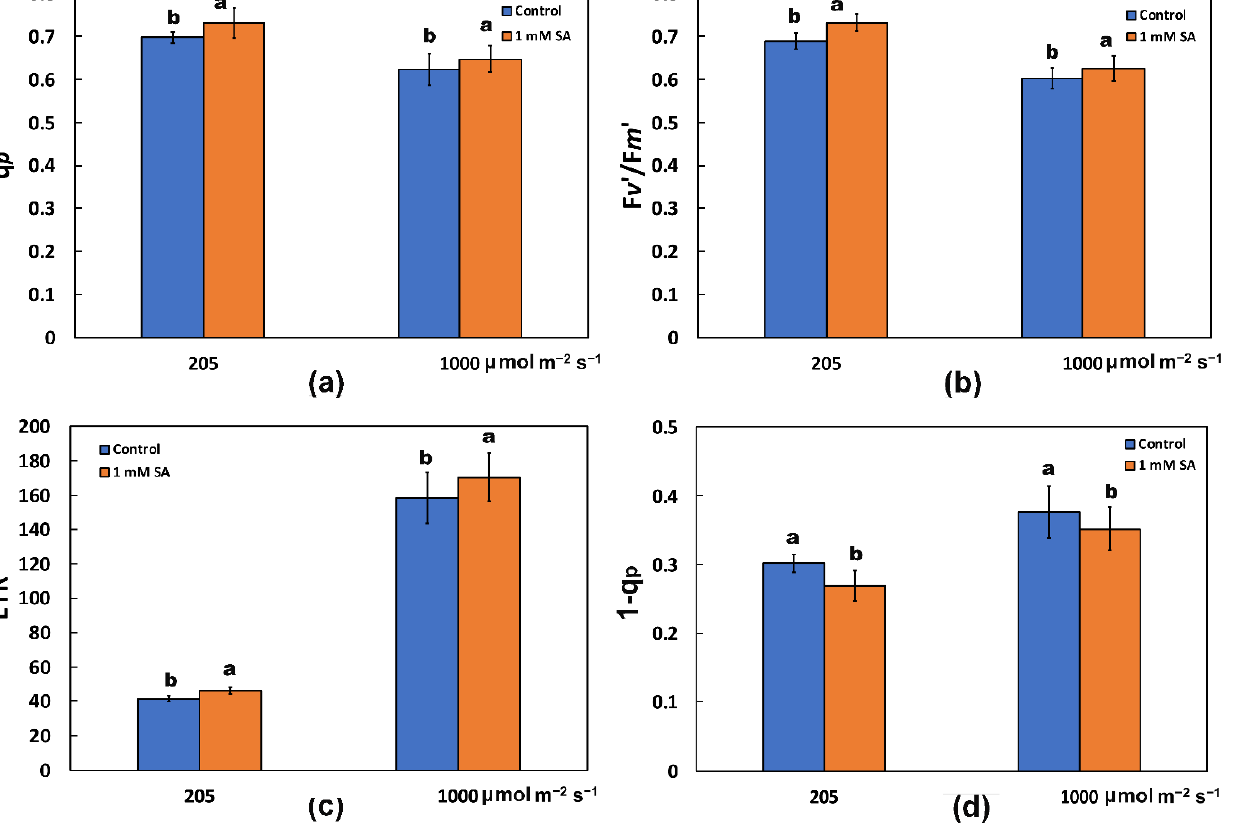
Figure 2. The fraction of open PSII reaction centers (q p ), a measure of the redox state of quinone A (Q A ) ( a ); the efficiency of excitation energy capture by open photosystem II reaction centers (F v ’/F m ’) ( b ); the electron transport rate (ETR) ( c ); and the excitation pressure (1 − q p ) (data from a) ( d ); estimated at 205 and 1000 µ mol photons m − 2 s − 1 actinic light (AL) intensity in tomato leaves, after 72 h of foliar spray by either distilled water (control) or 1 mM salicylic acid (SA). Error bars are standard deviations ( n = 4). Columns with different lowercase letters are statistically different ( p <